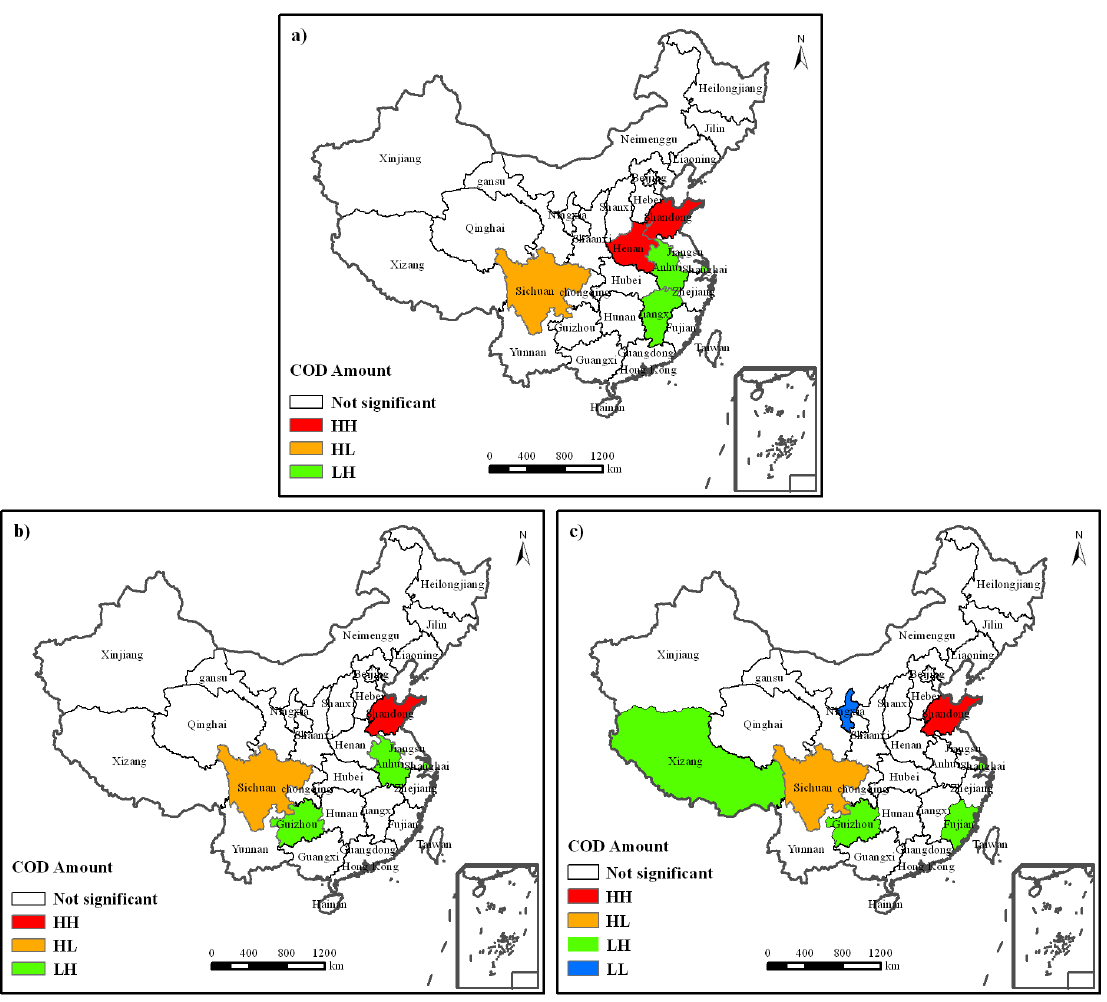
Figure 4. LISA cluster map of industrial COD discharge amount. Temporal and spatial variations of industrial COD discharge amount are divided into three phases. ( a ) Its status during the “9th Five-Year” period; ( b ) Its status during “10th Five-Year” period; and ( c ) Its status during “11th Five-Year” period. HH means High-High spatial pattern; HL means High-Low spatial pattern; LH means Low-High spatial pattern; LL means Low-Low spatial